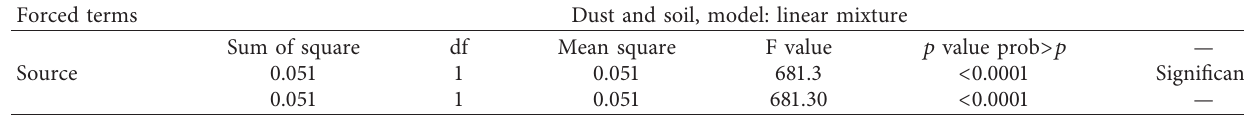
Table 11: ANOVA for unit weight of bricks.